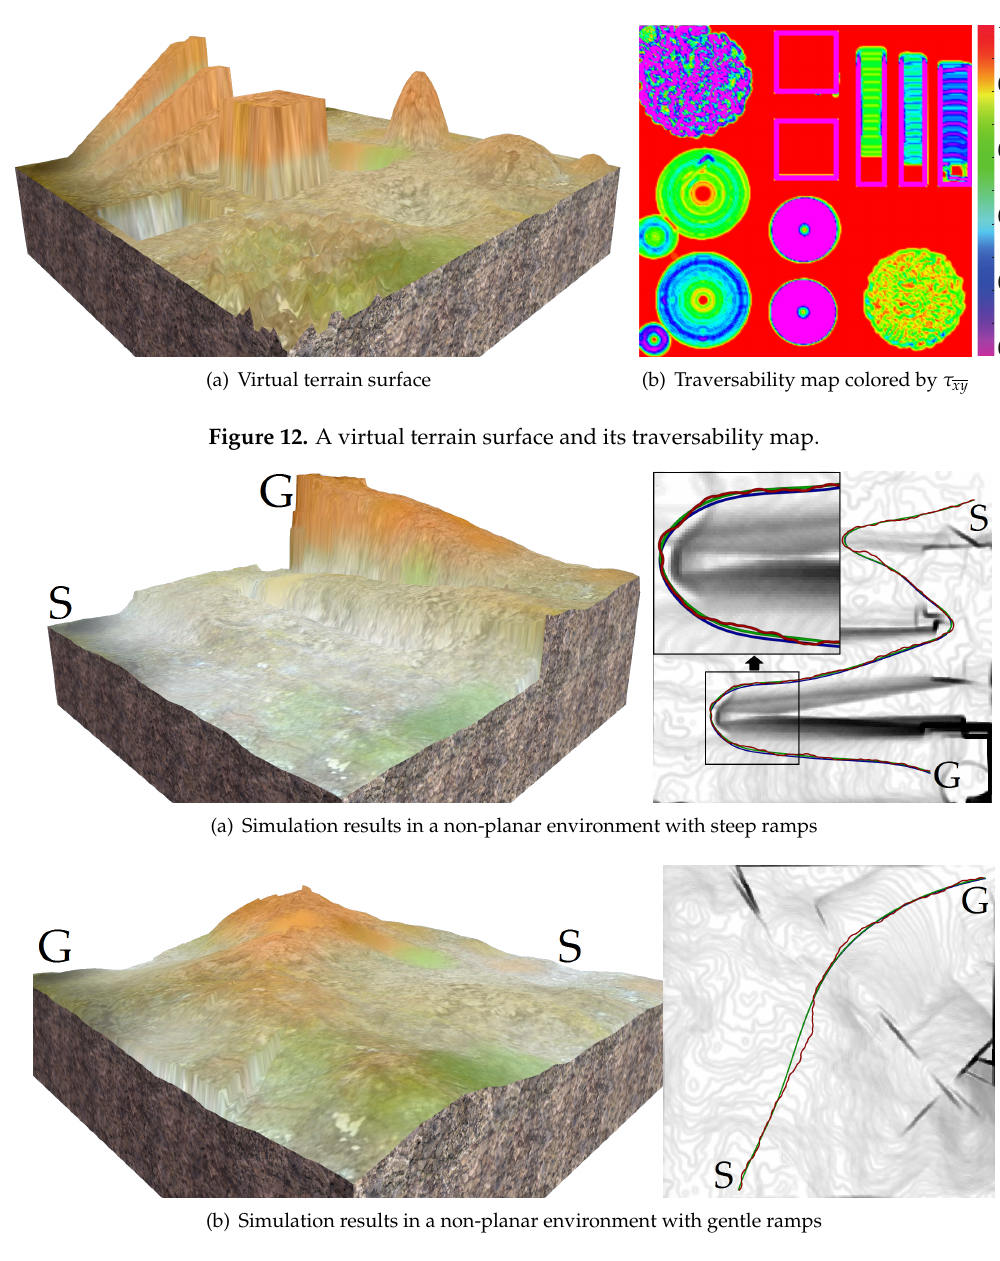
Figure 13. The initial paths (red), the trajectories (green) after optimization, and the real trajectories (blue) of the vehicle on the virtual terrain surfaces. For clarity, the trajectories are drawn on the grayscale traversability